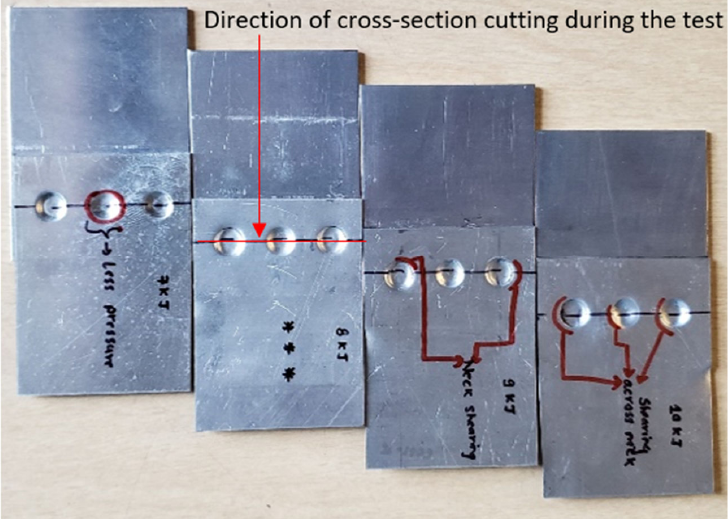
Figure 9. Multi ‐ spot EMJ samples by four different input energies: 7, 8, 9 and 10 kJ. Figure 9. Multi-spot EMJ samples by four different input energies: 7, 8, 9 and 10 kJ. Table 3. Visual inspection of the joint produced by EMJ at different discharge